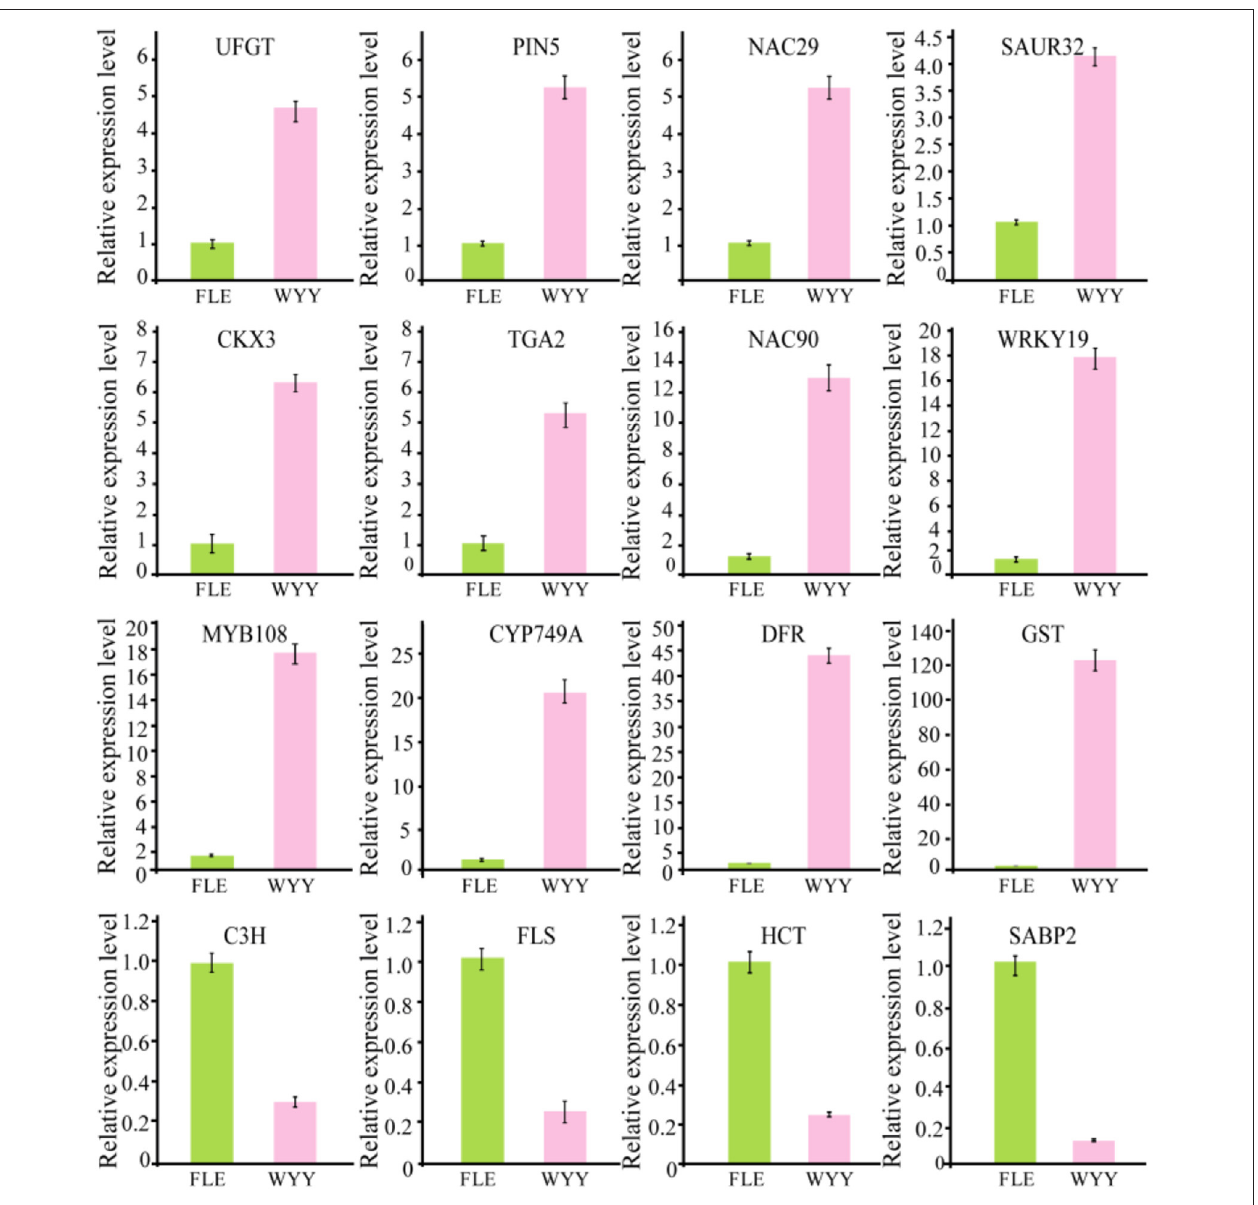
FIGURE 5 | Validation of RNA-seq data by qRT-PCR.